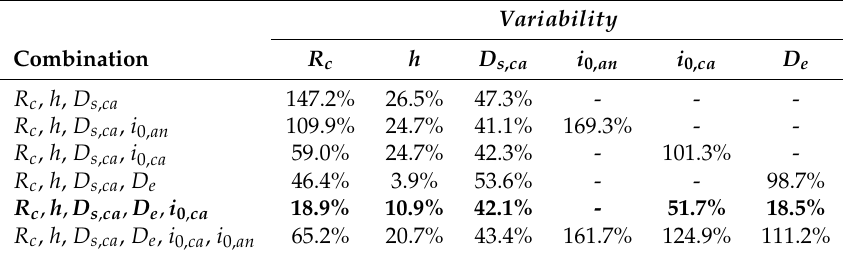
Table 7. Sample-to-sample parameter variability for different parameter combinations.